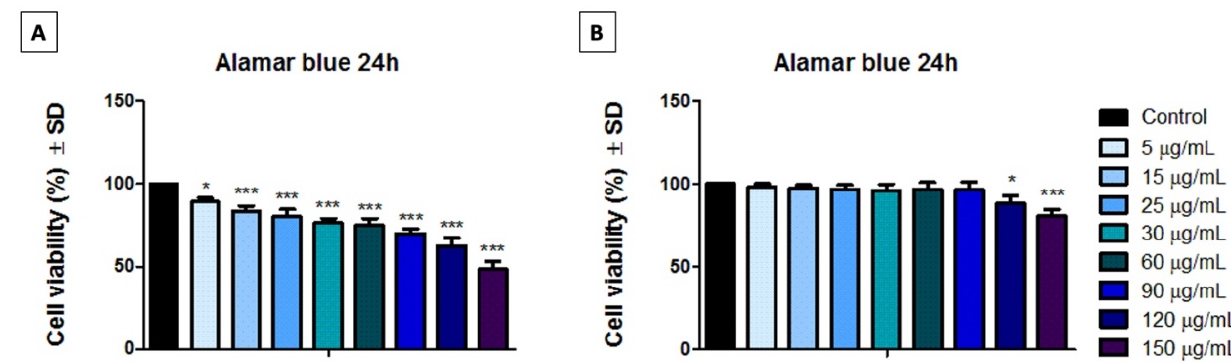
Figure 2. ( A ) Cell viability rate of human immortalized keratinocytes (HaCaT) after stimulation with different concentrations (5, 15, 25, 30, 60, 90, 120, 150 µg/mL) of Methotrexate for 24 h. ( B ) Cell viability rate of human immortalized keratinocytes (HaCaT) after stimulation with different concentrations (5, 15, 25, 30, 60, 90, 120, 150 µg/mL) of Cetuximab for 24 h. The graph bars are expressed as cell viability percentage (%) normalized to control cells (cells treated with culture medium). One-way analysis of variance (ANOVA) test was performed to determine the statistical differences of test sample versus control, followed by Tukey’s multiple comparisons post-test (* p < 0.05, *** p < 0.001).